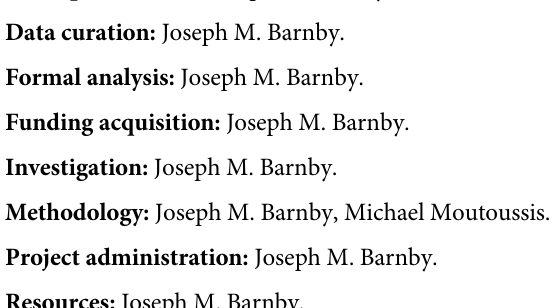
S12 Fig. Network analysis between social parameters and paranoia from Barnby et al., 2020. (A) Our nonparanormal network replicated results from Barnby et al., (2020). (B) Stabil- ity analysis demonstrated satisfactory case-dropping estimates. (C) Bootstrapped edge weights demonstrated satisfactory estimates. See S3 Table for all edge statistics in the network. S13 Fig. Isolated network to test collider bias between nodes. Paranoia is robustly correlated with pHI0 and u π ; the independent relationship between pHI0 and u π may therefore be at high risk of collider bias. S1 Table. Non-Social Associative Model Statistics. ‘RW’ refers to the Rescorla-Wagner (RW) / Q-learning learning model. ‘PH’ refers to the Pierce-Hall salience model. ‘WS’ refers to the ‘Win-Stay; Lose-Switch’ model. S2 Table. Social Model Comparison Statistics. LL, BIC, and AIC figures are indicative of the summed log probability from the combination of harmful intent and self-interest estimates for each model fitted using Maximum-A-Priori techniques. Bold highlighting represents winning models in each class. S3 Table. Bootstrapped estimates for each edge in the replication network. S4 Table. Top Model Average of Variables Associated with decision temperature ( τ ). All regression estimates are extracted from Model J2c in the analysis code. w the final top model and therefore excluded from this